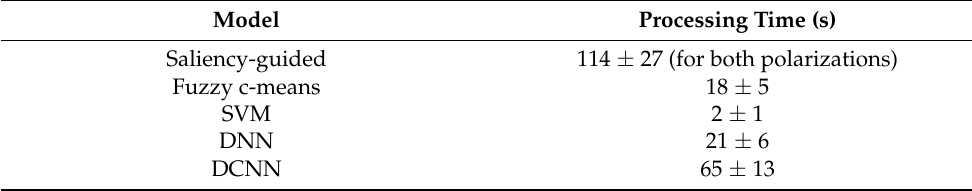
Table 4. Average time for each processing stage.